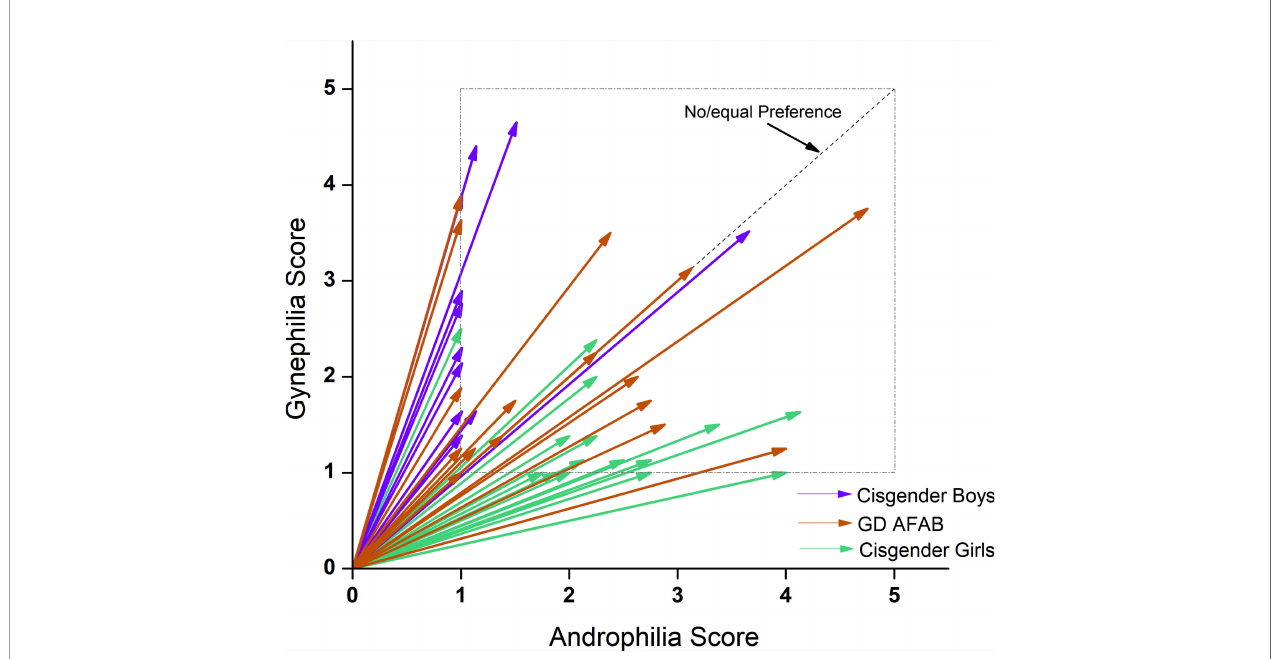
FIGURE 2 | EROS scores by group. Cisgender girls ( n = 17; green) were predominantly androphilic (< 45°), cisgender boys ( n = 15; purple) were predominantly gynephilic (> 45°) and GD AFAB adolescents ( n = 17; orange) expressed a range of sexual attraction